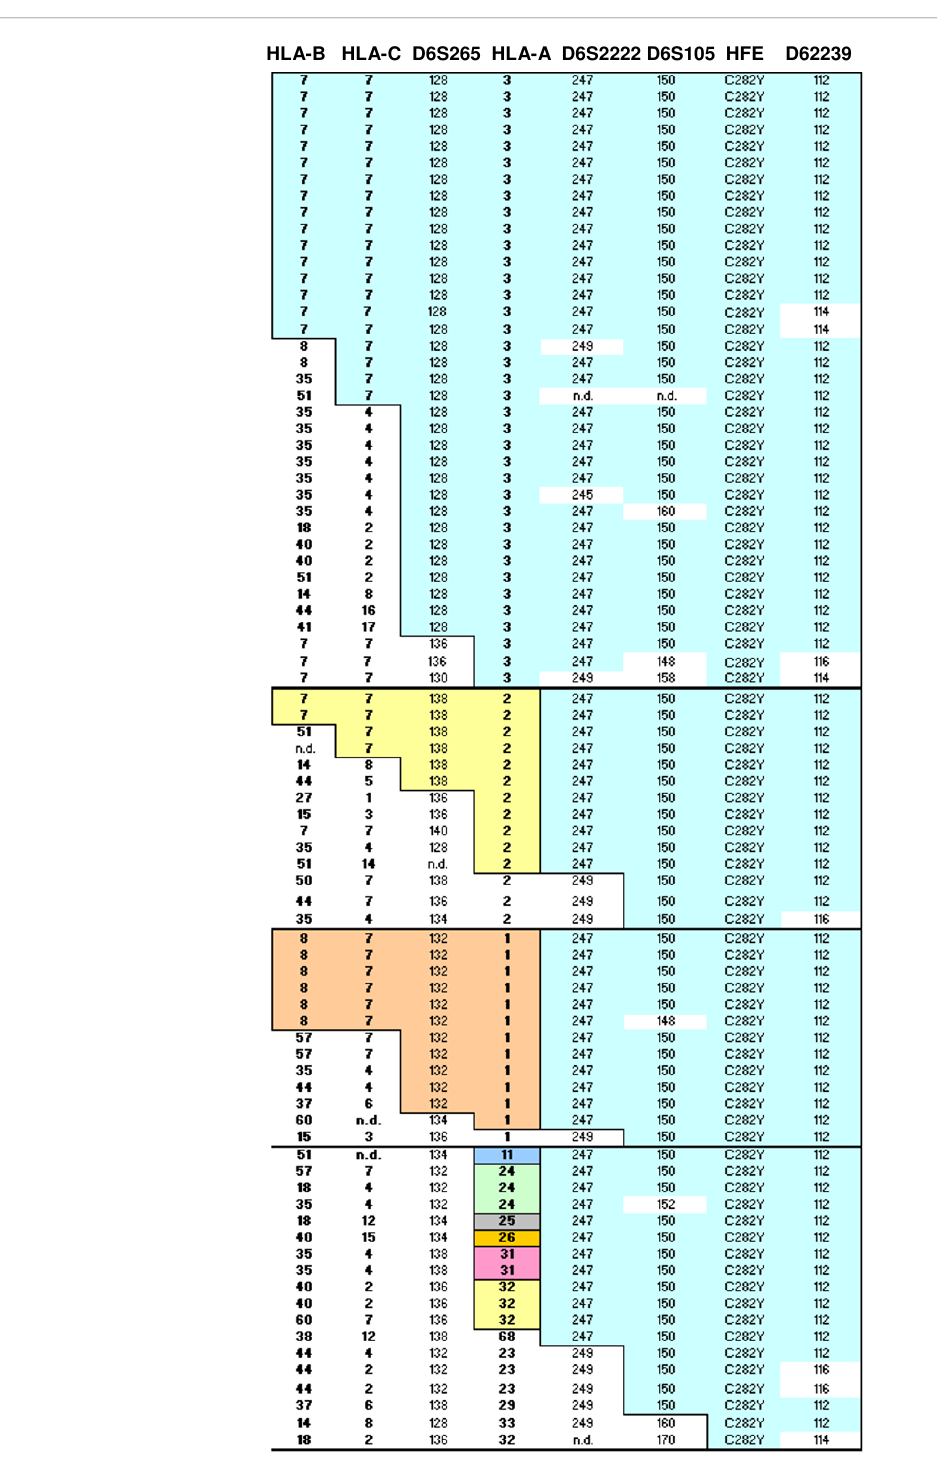
Figure 2 Multi-locus map of C282Y carrying haplotypes from a region spanning 5 Megabases from HLA-B to D6S2239. The allele specif- icity in each locus is represented by numbers corresponding to the size of the amplified DNA fragments. Color boxes repre- sent conserved haplotype areas. n.d.: not